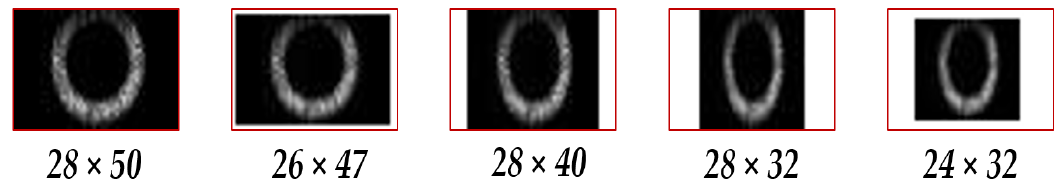
Figure 5. Example of an image resized for the sticky tape object; the red canvas is shown for illustration, which signifies the original image size (28 ×